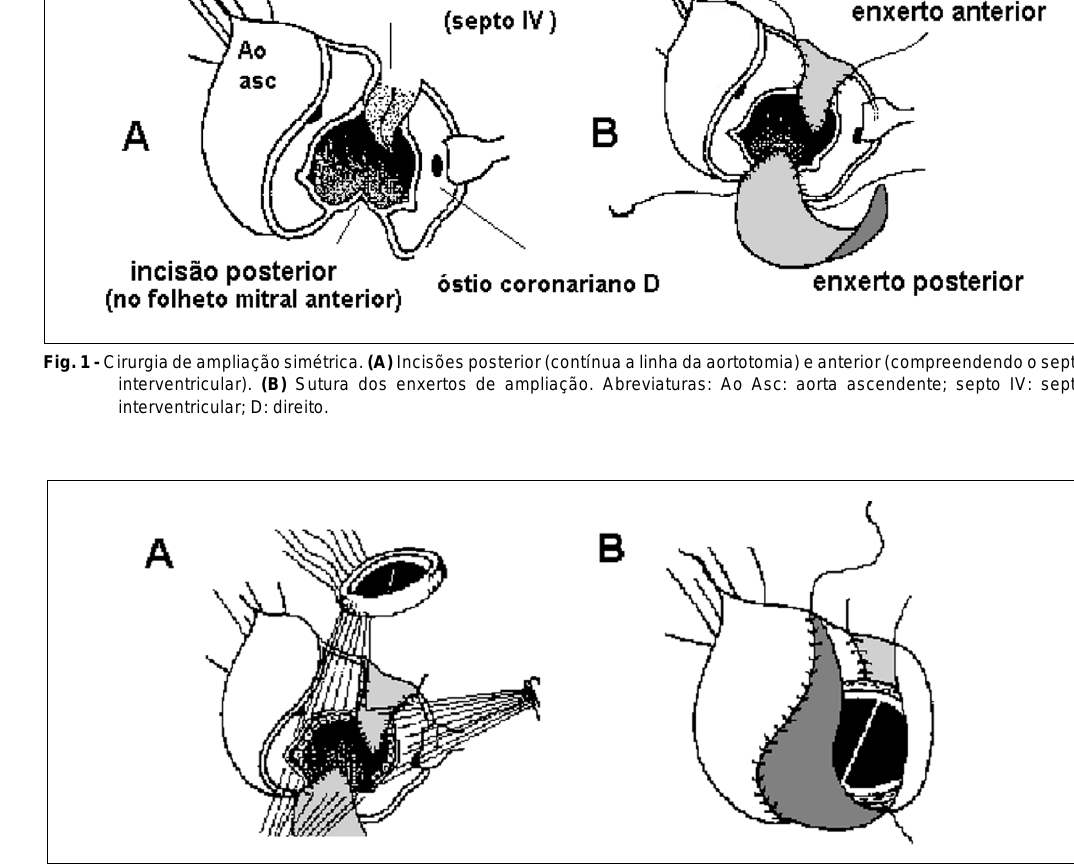
Fig. 2 - Conclusão da operação de ampliação: A . Pontos de fixação da prótese aórtica. B . Reconstrução da parede aórtica com os enxertos de pericárdio bovino utilizados na ampliação